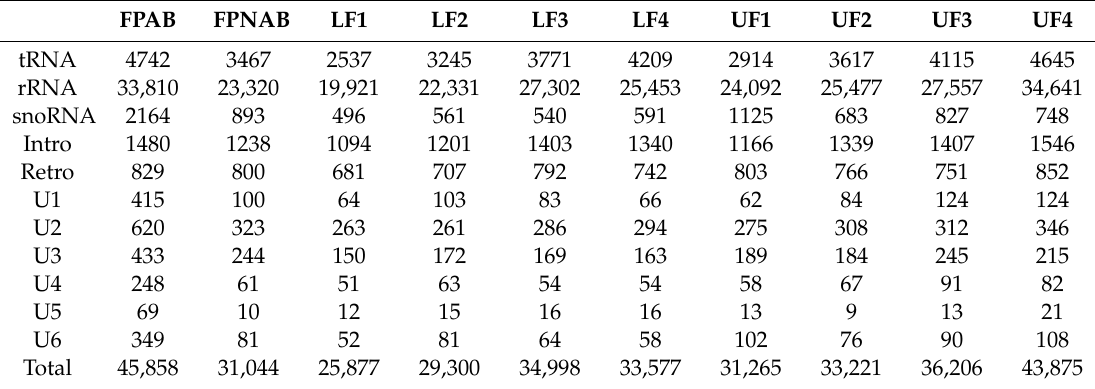
Table 2. Rfam annotation